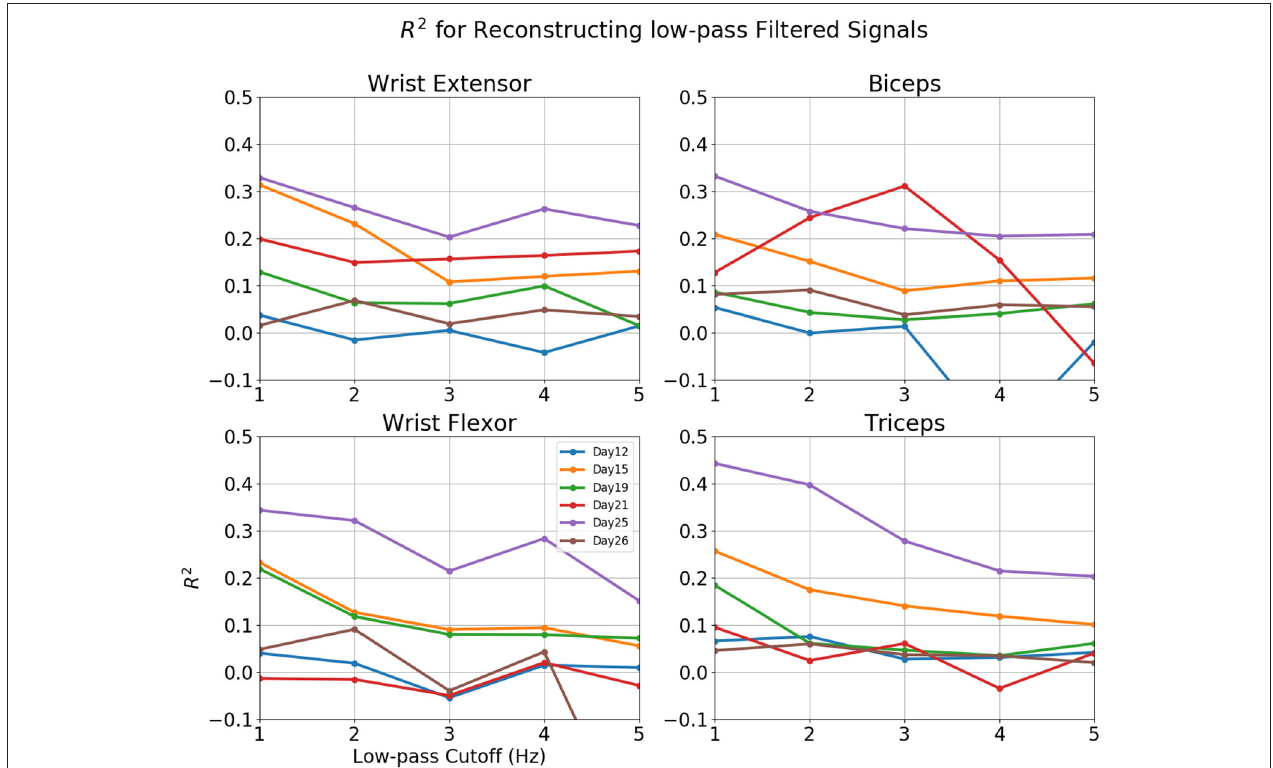
FIGURE 8 | R 2 -value for reconstruction of low pass filtered EMG for various sessions of rat 3. Horizontal axis: Cut-off frequency for EMG, 0–5 Hz. Vertical Axis, R 2 . Each line represented a different